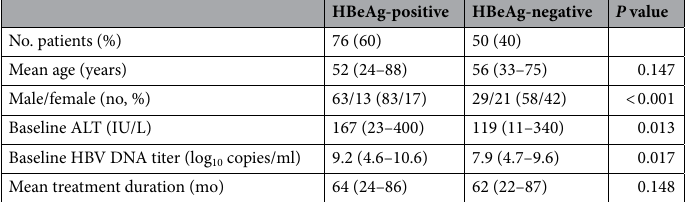
Table 1. Baseline clinical characteristics of 126 patients with chronic hepatitis